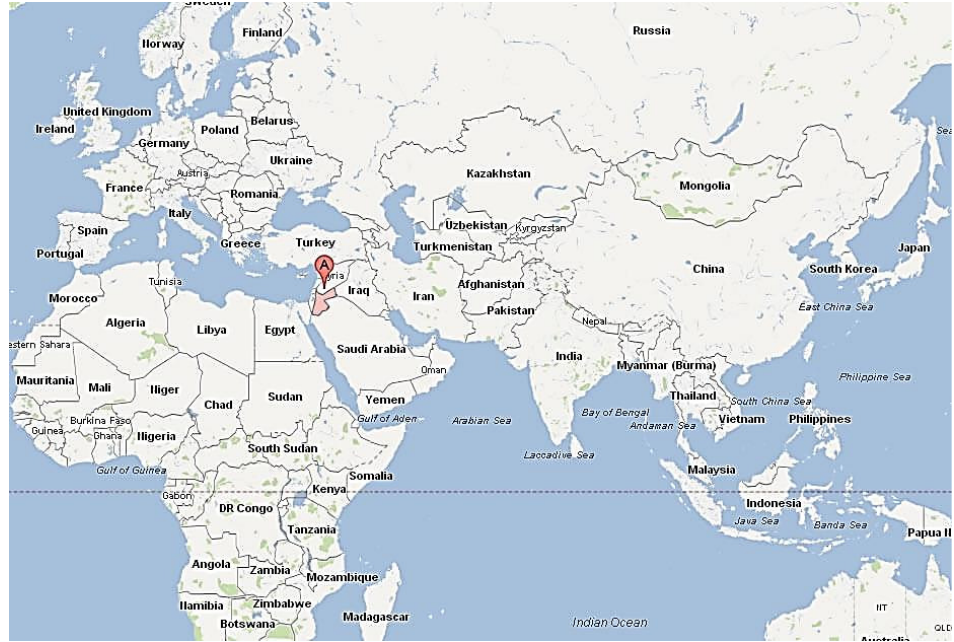
Figure 1. Location of Jordan (Google Maps)